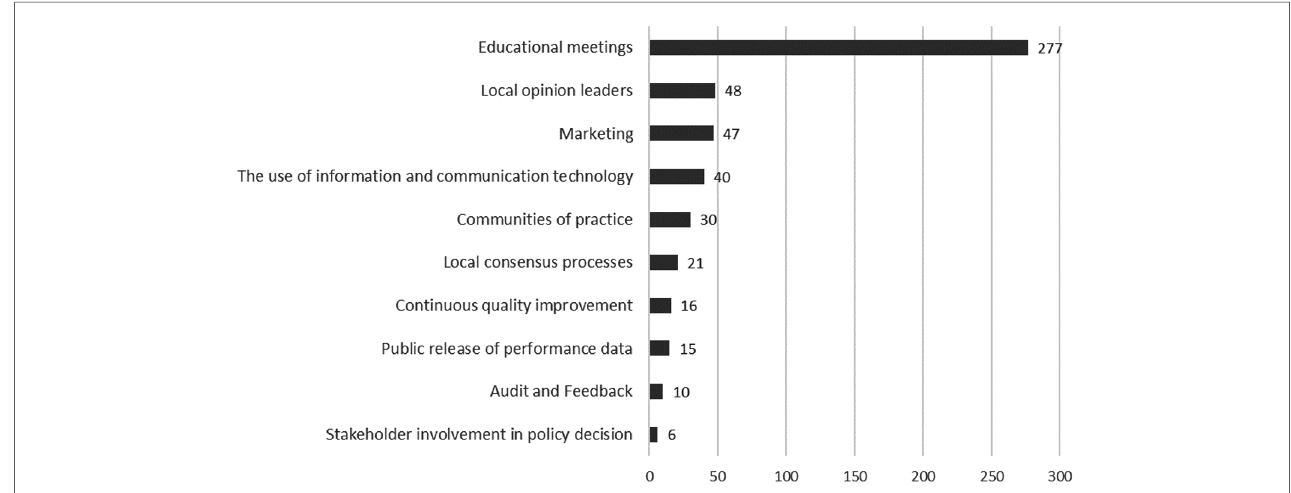
FIGURE 4 Dissemination activities from April 2019 to September 2022 ( n =510), categorized according to the EPOC taxonomy (65). An activity can be assigned to several